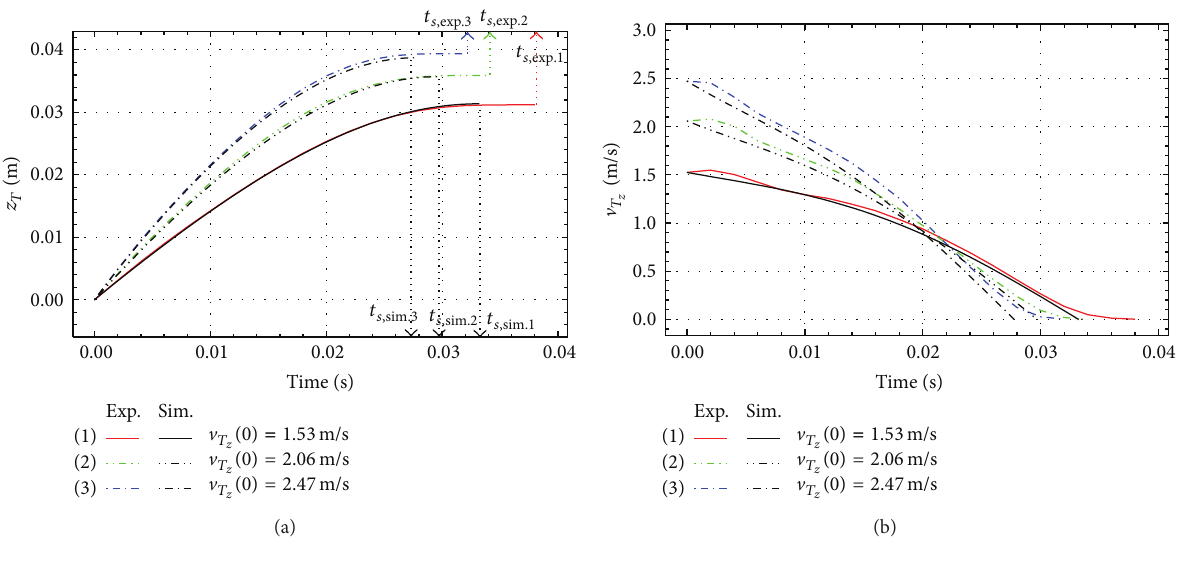
Figure 6: Experimental and simulation results for 𝑞(0) = 0 ∘